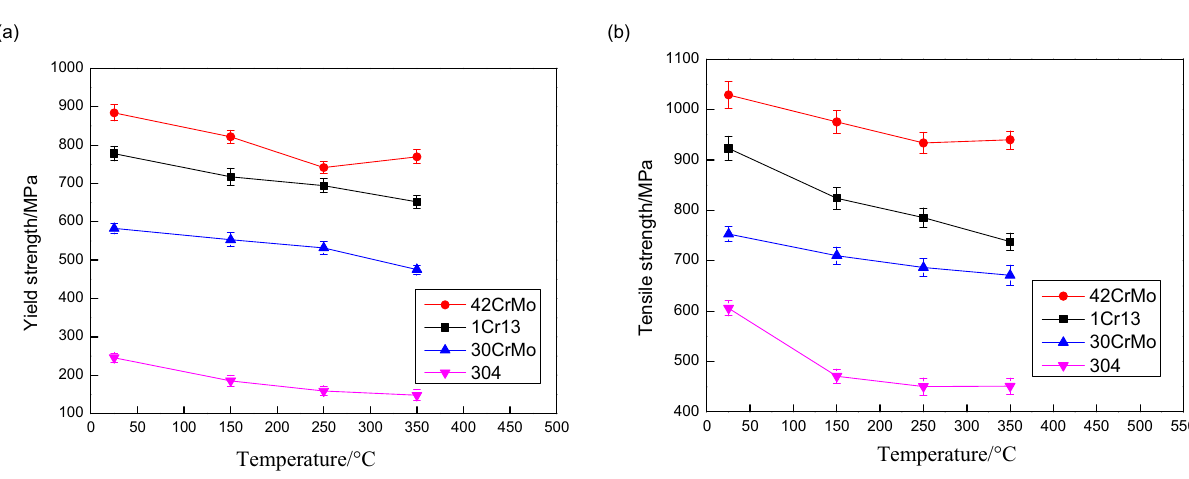
Figure 3: Strength curves of 30CrMo, 42CrMo, 1Cr13, and 304 steels at 25, 150, 250, and 350°C: ( a ) yield strength and ( b ) tensile